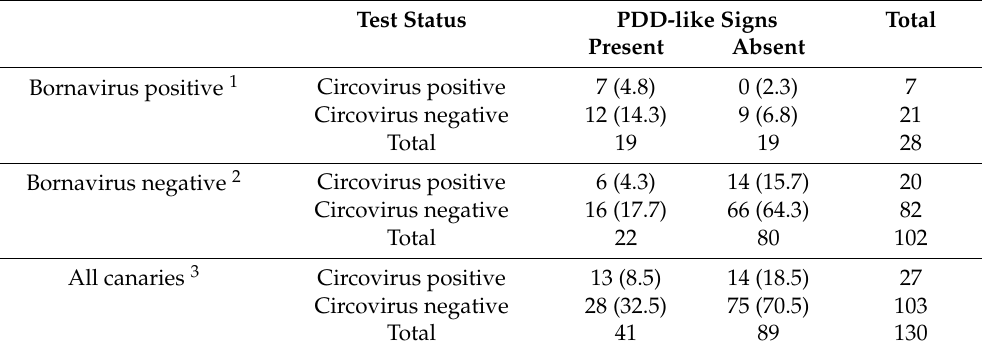
Table 5. Cross table for the number of canaries with positive or negative bornavirus tests as well as circovirus tests and occurrence of proventricular dilatation disease (PDD)-like signs. Expected counts for perfectly independent variables are given in